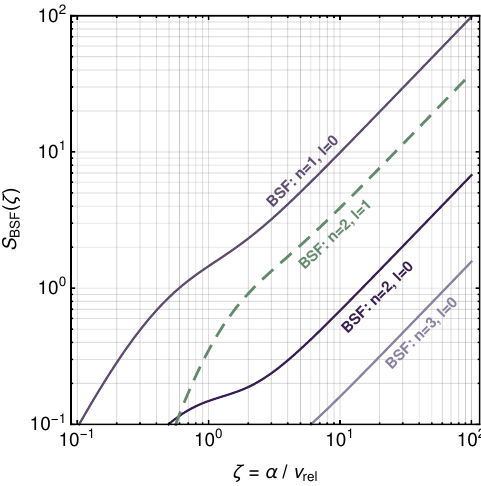
Figure 9 . Velocity dependence of the S BSF factors for the radiative bound-state formation by a bosonic particle-antiparticle pair coupled to a nearly massless scalar. n and ‘ denote the principal and the angular-momentum quantum number of the bound states formed. For cap- ture into ‘ = 1 states, we have summed over all m (the angular-momentum projections on one axis). Annihilation (not shown here) is the dominant inelastic process; in the Coulomb regime, (cid:27) f 100 g =(cid:27) sc = (cid:11) 2 S f 100 g ( (cid:16) ) =S (0) ann ( (cid:16) ) ’ 0 : 16 (cid:11) 2 , at (cid:16) = (cid:11)=v rel (cid:29) 1 [cf. eqs. (4.11), (4.13), ann BSF BSF